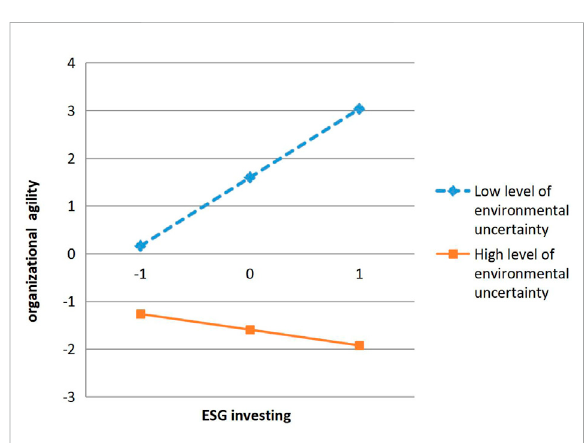
FIGURE 2 The interaction effect of environmental uncertainty on ESG investment and organizational